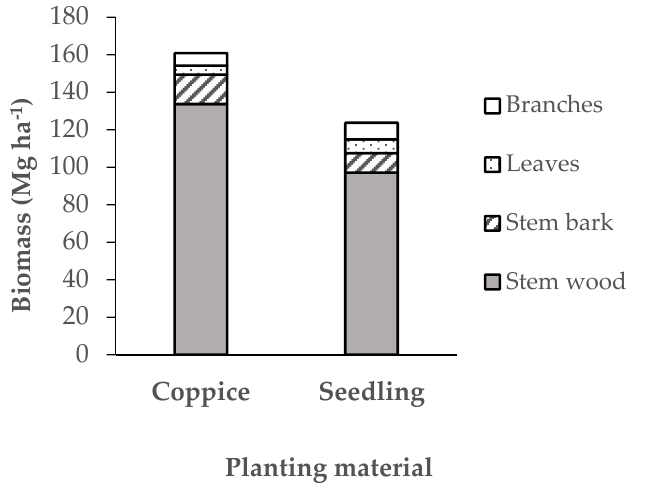
Figure 2. Biomass production of Eucalyptus pellita from different planting materials at age six years.